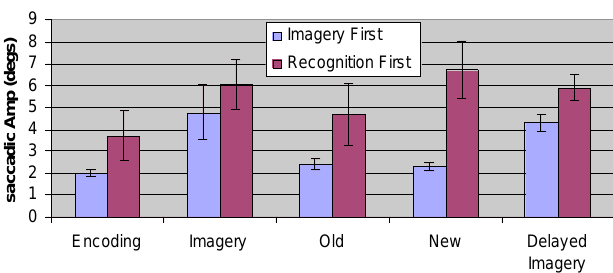
Figure 8: Differences in average saccadic amplitude be- tween The Imagery First group and The Recognition First group and between phases of the course of the experi-